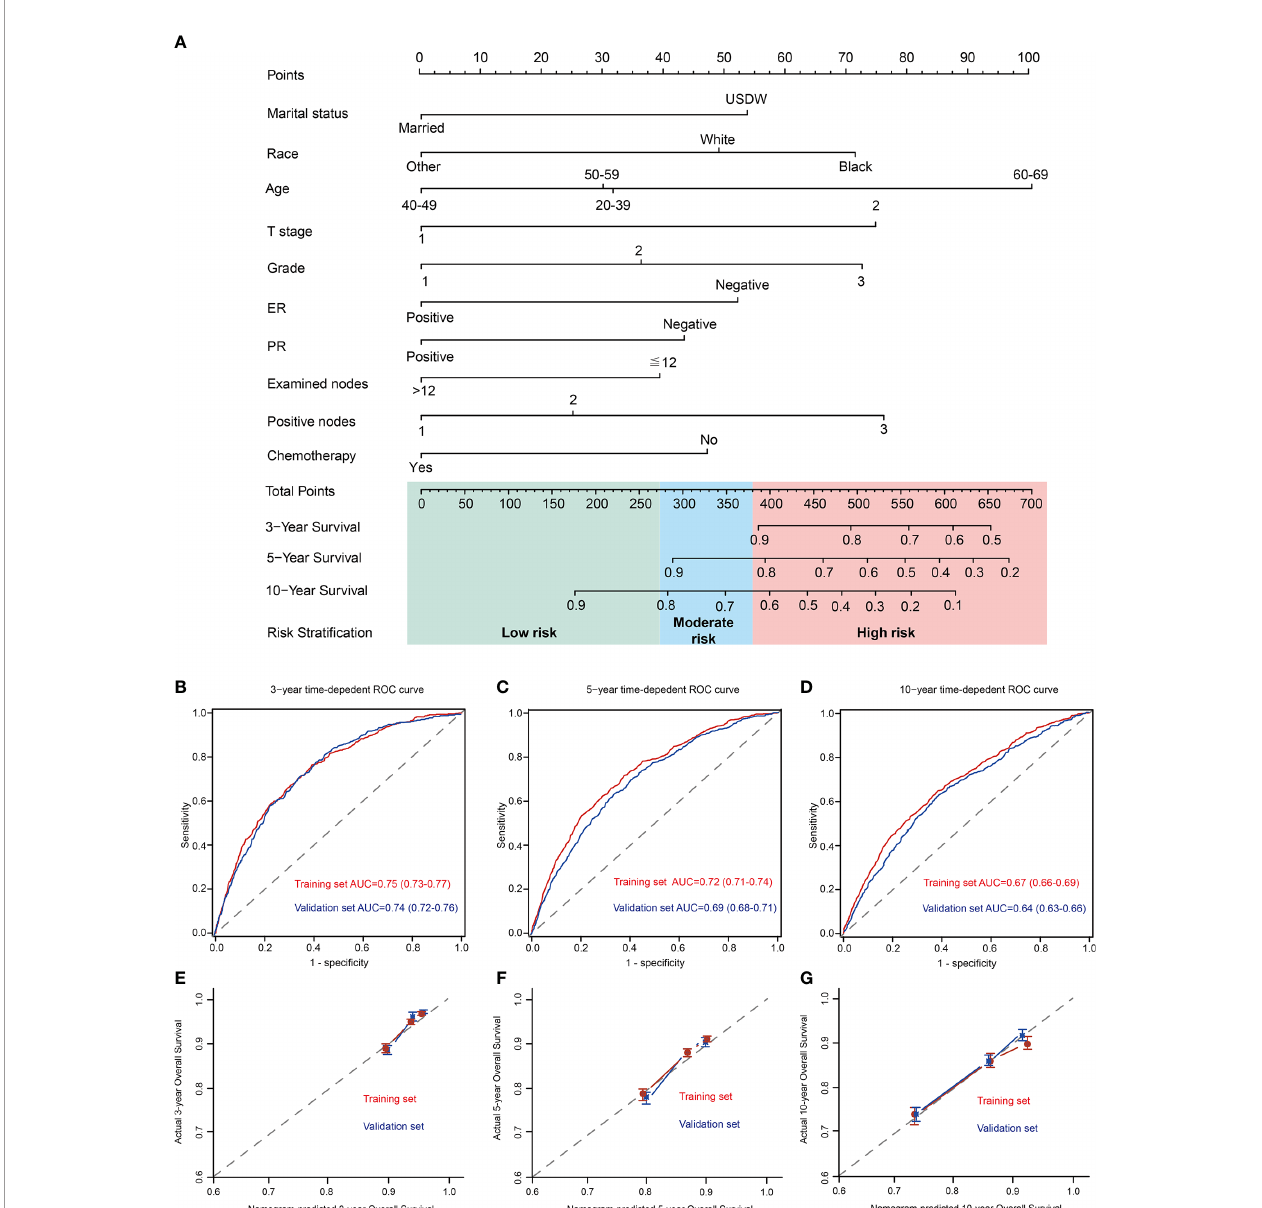
FIGURE 2 | Development of a prognostic strati fi cation nomogram and validation of the proposed nomogram. (A) a prognostic strati fi cation nomogram to accurately predict overall survival for T1 – 2 breast cancer with 1 – 3 positive lymph nodes. (B – D) ROC curves for predicting the overall survival in the internal and external validation at 3-year, 5-year, and 10-year, respectively. The values in brackets of Figure 2B – D represent the area under the ROC curves (AUC). (E – G) the calibration curves for predicting patients ’ overall survival in the internal and external validation at 3-year, 5-year, and 10-year, respectively. USDW, unmarried/separated/ divorced/widowed; Other, American Indian/AK Native, Asian/Paci fi c Islander; grade 1, well differentiated; grade 2, moderately differentiated; grade 3, poorly differentiated/undifferentiated; ER, estrogen receptor; PR, progesterone